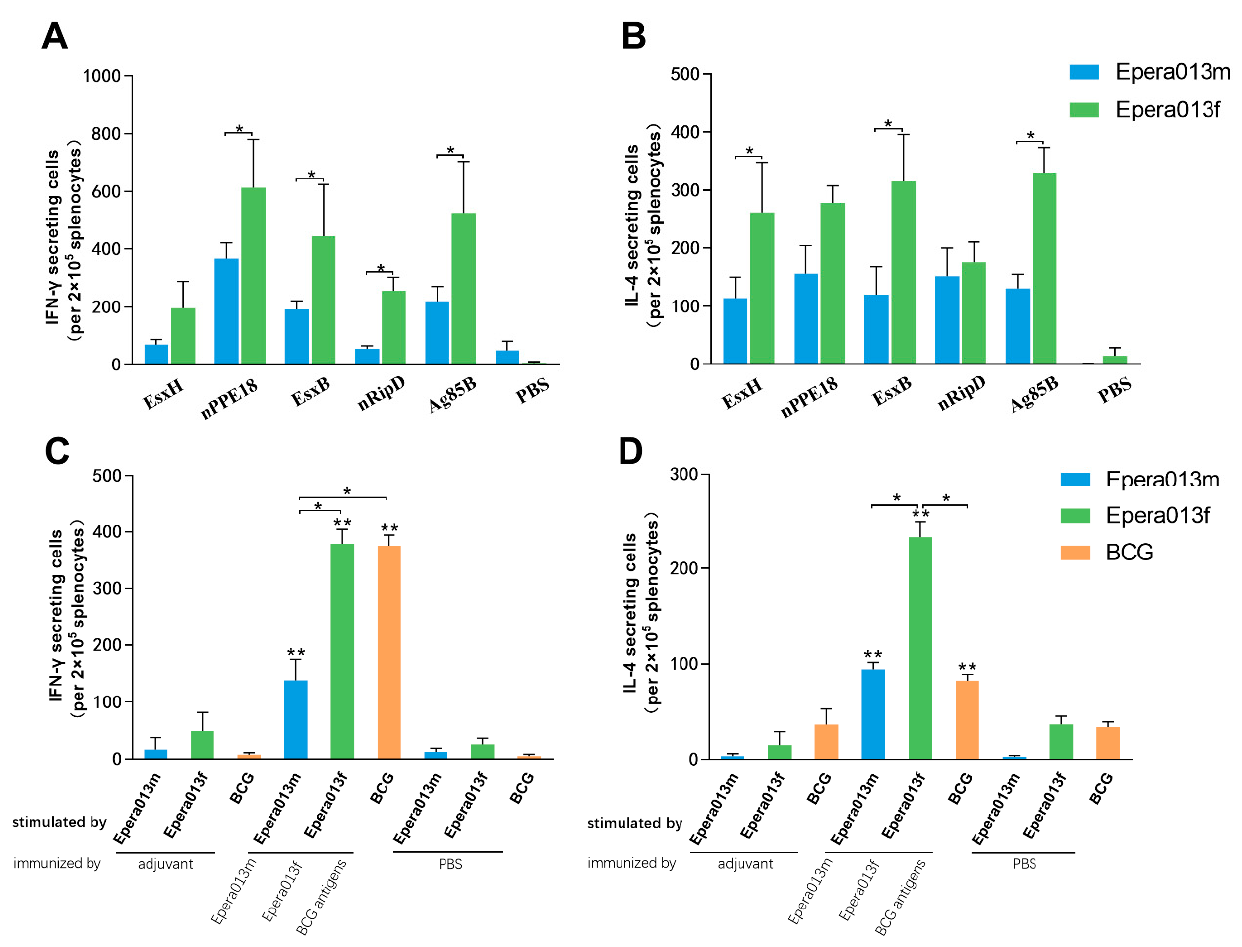
Figure 5. Results analysis of antigen-specific IFN- γ and IL-4 secretion levels of immunized mice among Epera013f, Epera013m and BCG groups ( n = 6 for each group, mean values ± S.E.M.). ( A ) IFN- γ and ( B ) IL-4 secreting cells in response to the five individual protein restimulation. ( C ) IFN- γ and ( D ) IL-4 secreting cells in response to Epera013f, Epera013m and BCG antigens restimulation. Significant statistical differences between adjuvanted antigen/BCG groups and PBS/adjuvant control groups stimulated with corresponding antigens or BCG antigens were represented by asterisks above the error bars. Significant statistical differences among Epera013f, Epera013m and BCG groups were presented by capped lines with asterisks. Values were from three independent experiments. Statistical analysis of the numbers of IFN- γ and IL-4 secreting cells between groups were performed with one-way ANOVA and LSD (Least Significant Difference) multiple comparison test. (* p < 0.05, ** p < 0.01). IFN- γ , interferon- γ ; IL, interleukin. splenocytes restimulated with Epera013f, Epera013m or BCG antigens were